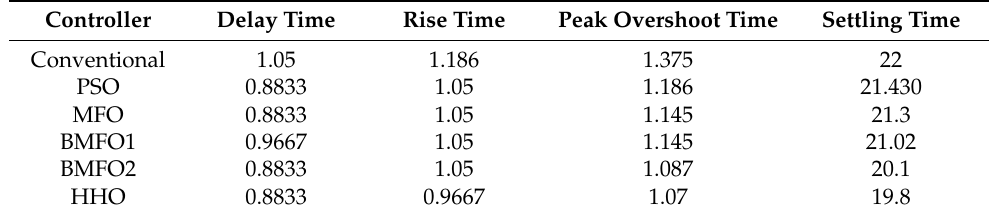
Table 3. Graph analysis of Area1 frequency with various controllers under unilateral contract.